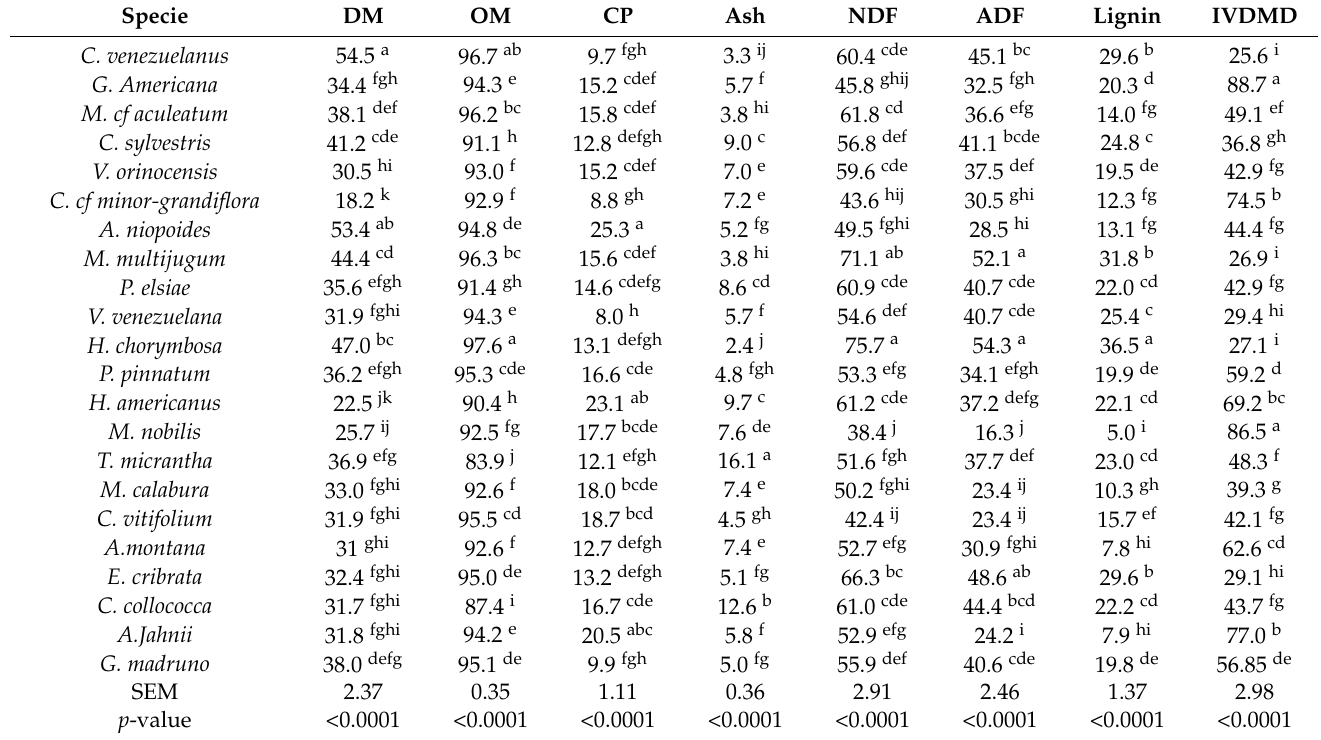
Table 2. Nutritional characteristics (%) of arboreal plants on dry matter